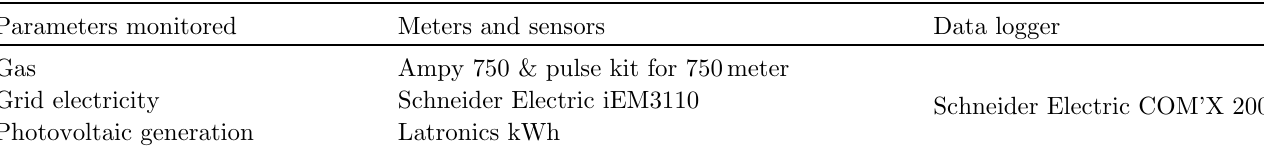
Table 1. Monitoring equipment installed in the ten